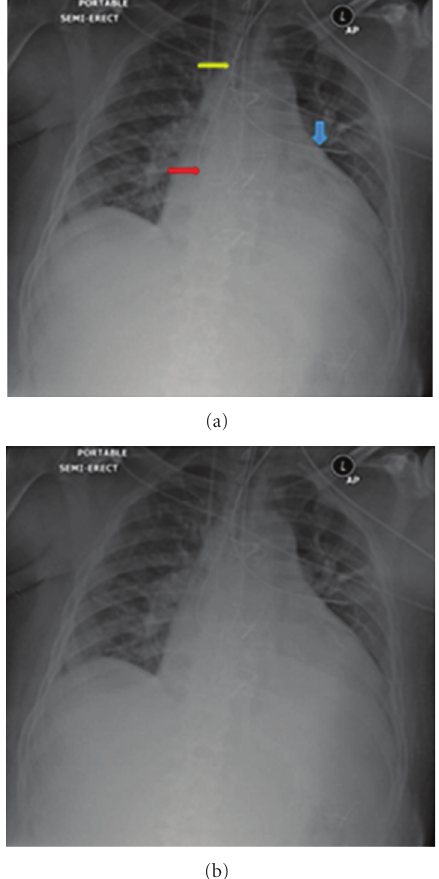
Figure 33: The NGT loops in the trachea (red arrow), then reenters the oropharynx, makes a further loop in the oropharynx, and returns to the trachea (yellow arrow), and finally the tip ends into the left, upper lobe bronchus probably the lingular bronchus (blue arrow).